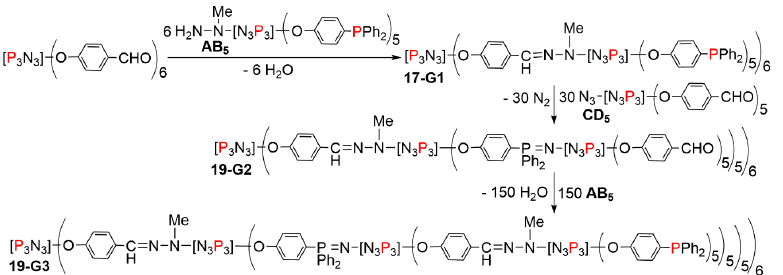
Scheme 19. Synthesis of the third generation dendrimer 19-G3 in only 3 steps, functionalized with 750 phosphine terminal functions.